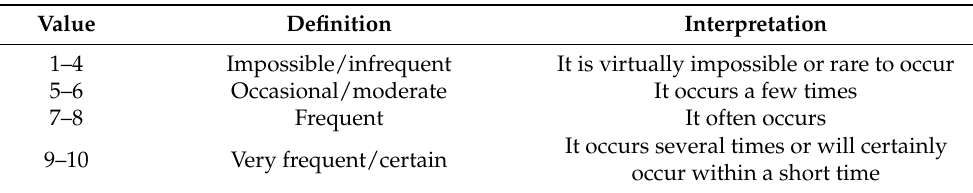
Table 1. Occurrence scale. 1–10 ranking correlates with the progressive increase in the likelihood of occurrence of a failure mode during bioprinting.